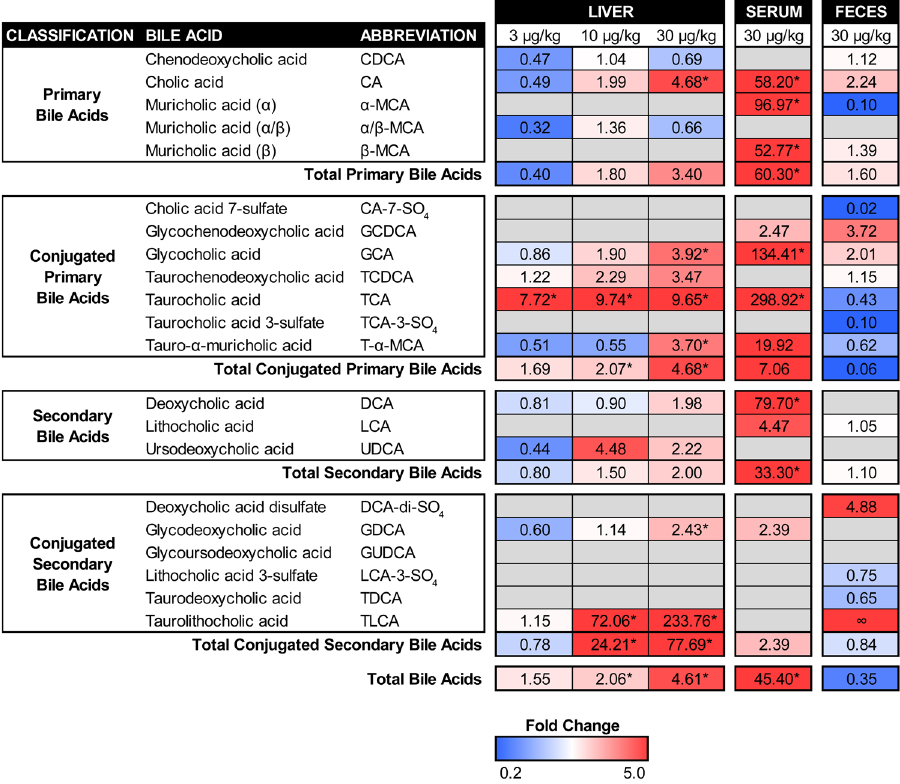
Figure 4. Bile acid profiles for the liver, serum, and feces of male C57BL/6 mice orally gavaged with sesame oil vehicle or TCDD (3–30 µ g/kg) every 4 days for 28 days. Individual bile acid species were quantified using high resolution accurate mass liquid chromatography mass spectrometry and expressed as fold changes relative to vehicle controls. Red and blue indicate increased or decreased levels, respectively, while grey indicates ‘not detected’. ‘ ∞ ’ indicates an incalculable increase as the bile acid was detected in treated animals but not controls. Statistical significance ( * p ≤ 0.05) was determined using one-way ANOVA analysis followed by Dunnett’s post- hoc test (liver) or a Student’s t-test (serum) performed in SAS 9.3. Fecal pellets were collected from two cages of co-housed mice for each treatment group (n = 2) and therefore statistical analysis was not